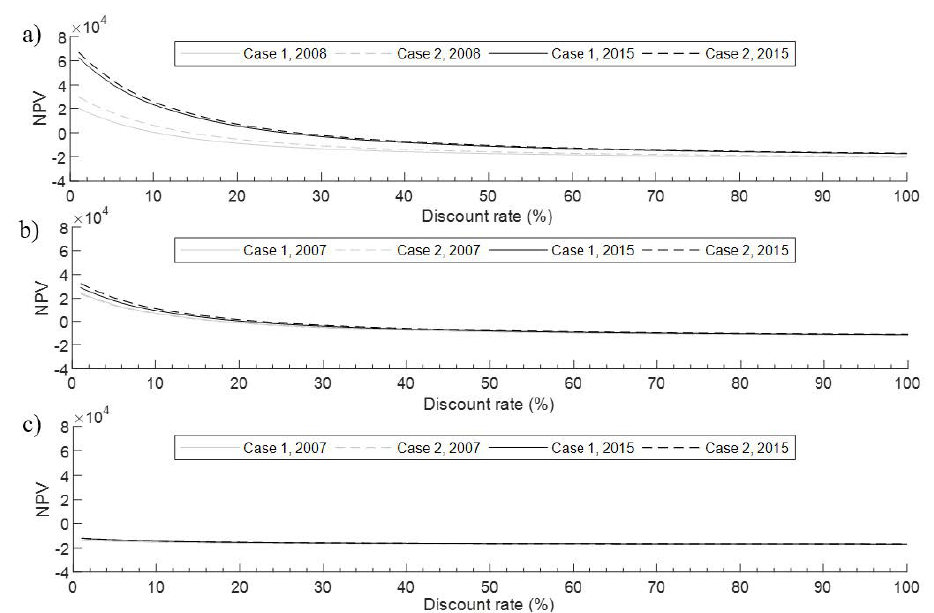
Figure 16. Net present value for several discount rates of the speed variable drive investment for WUA A ( a ), WUA B ( b ), and WUA C ( c ).